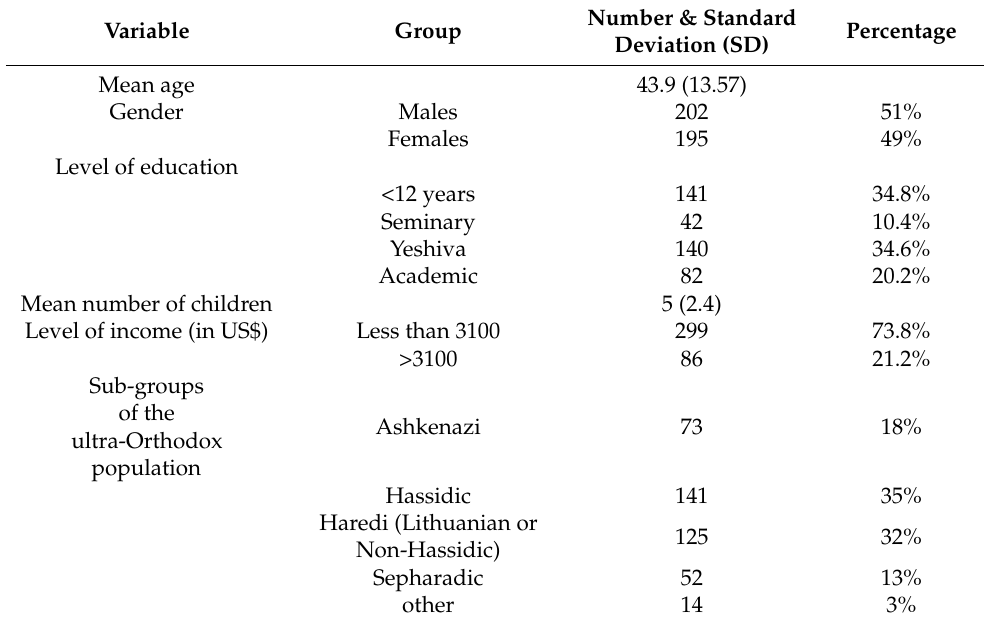
Table 1. Characteristics of study population ( N =